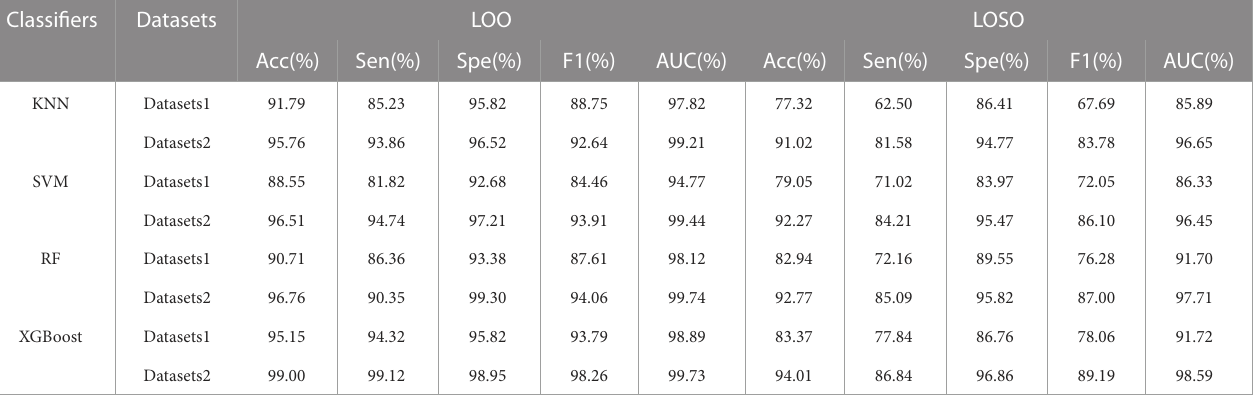
TABLE5 LOOandLOSOclassificationresultsforHFdiagnosticsover2datasetsusing4classifiers.Datasets1:HFpatientsofBCGeasilylocalizedandhealthy subjectssamples.Datasets2:HFpatientsofBCGnoteasilylocalizedandhealthysubjectssamples.